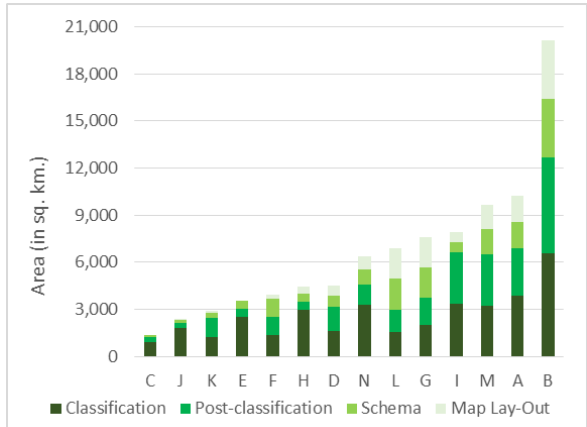
Figure 13. QA/QC Statistics based on Area of Submitted Blocks